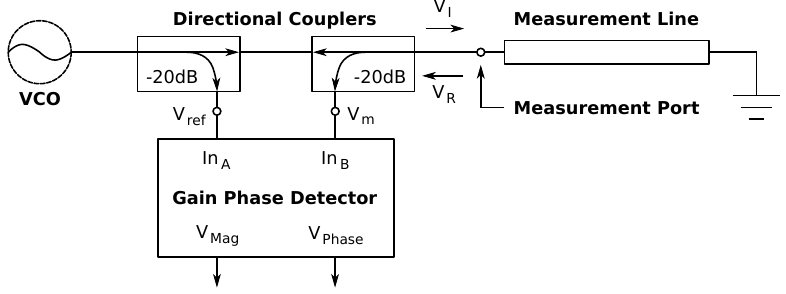
Figure 15. Schematic of the reflectometer circuit connected to